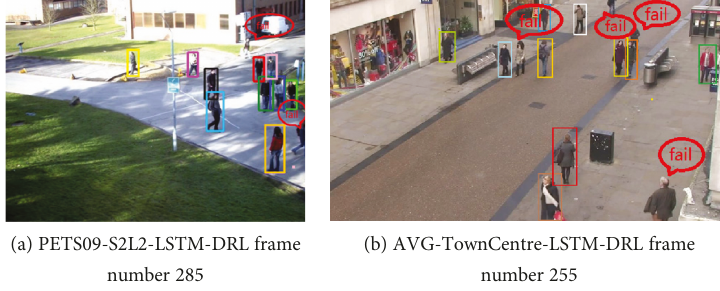
Figure 15: Some selected failure results of our tracker.